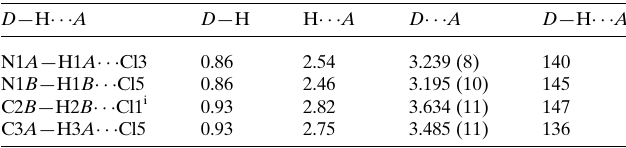
Table 1 Hydrogen-bond geometry (A˚ , (cid:2)